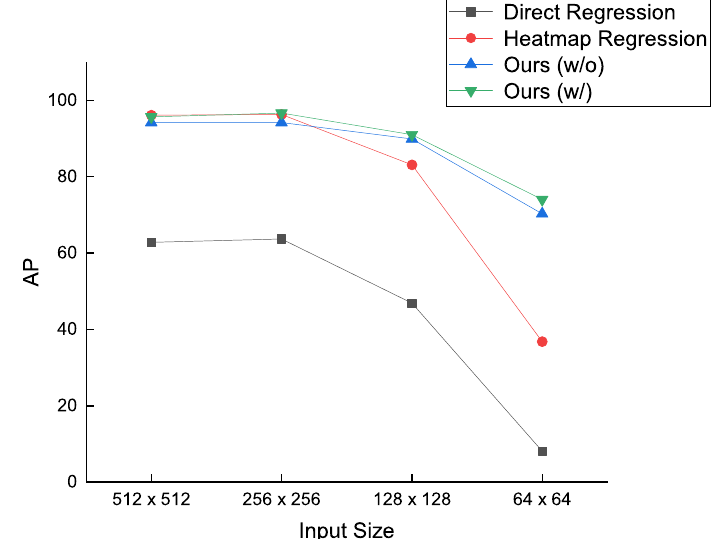
Figure 10. Comparison between our methods and the state-of-the-art methods in terms of the AP metric at all input size conditions.